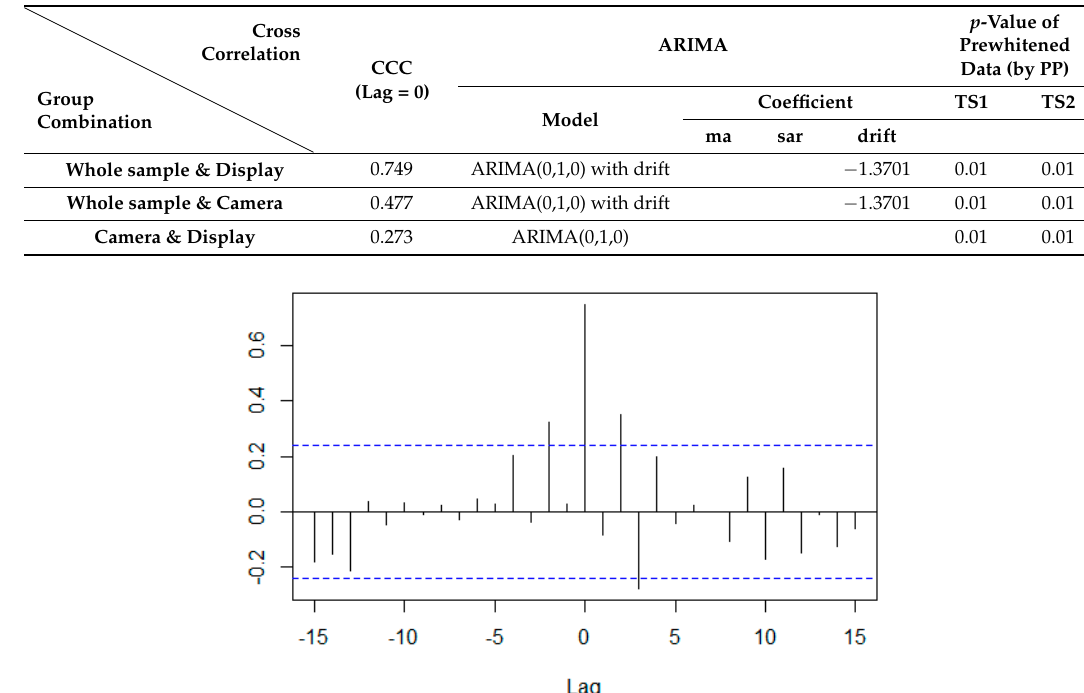
Figure 10. Cross-correlation coefficient between the average CAR of the whole sample group and the average CAR of the display group for Evaluation period: Jan 2010–Dec 2011, Event period: Jan 2013–Jul 2018.